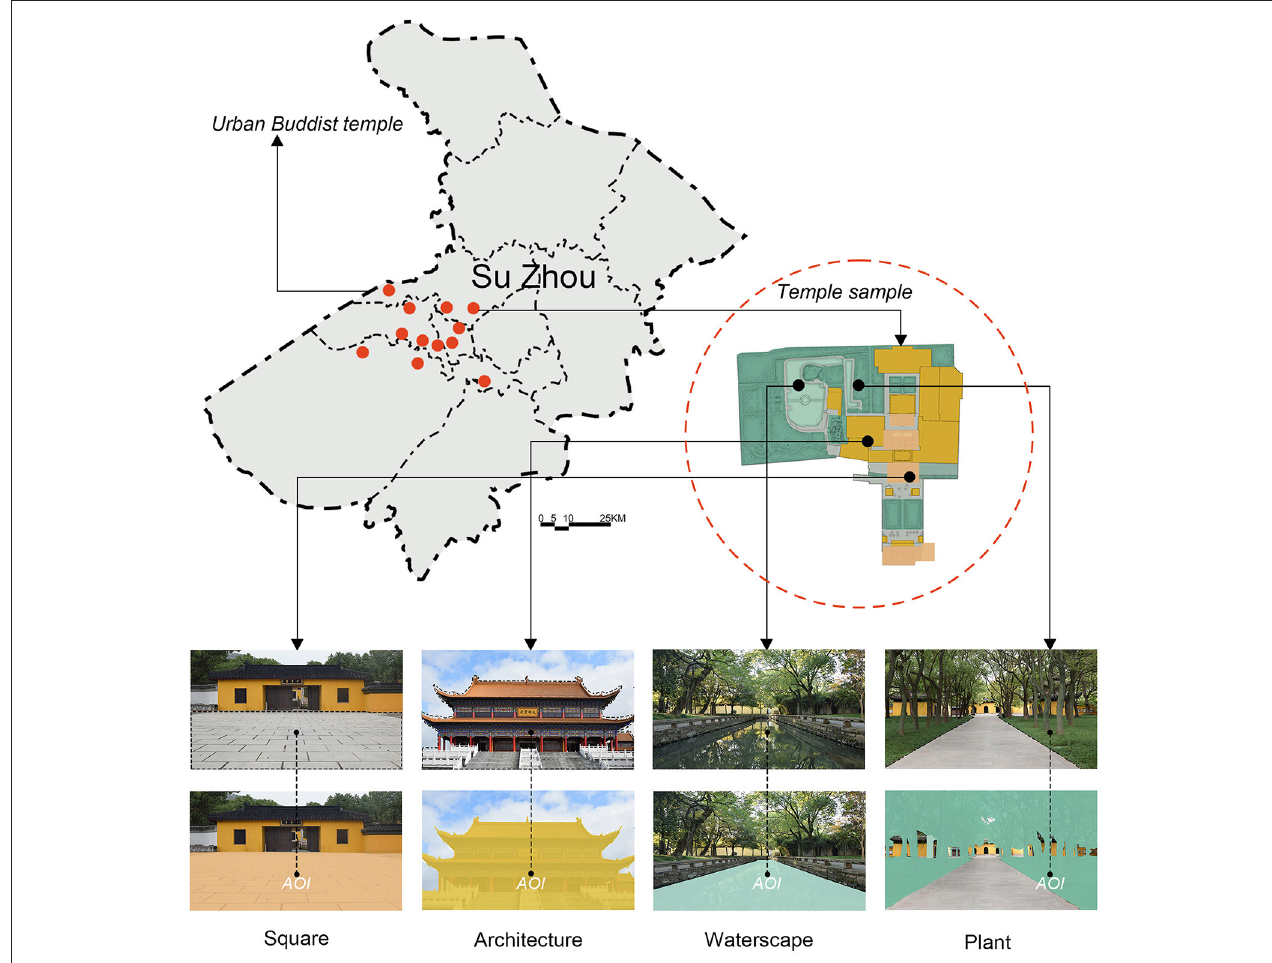
FIGURE 1 | Locations of the sacred landscape sampling sites in Suzhou, and the four representative landscape